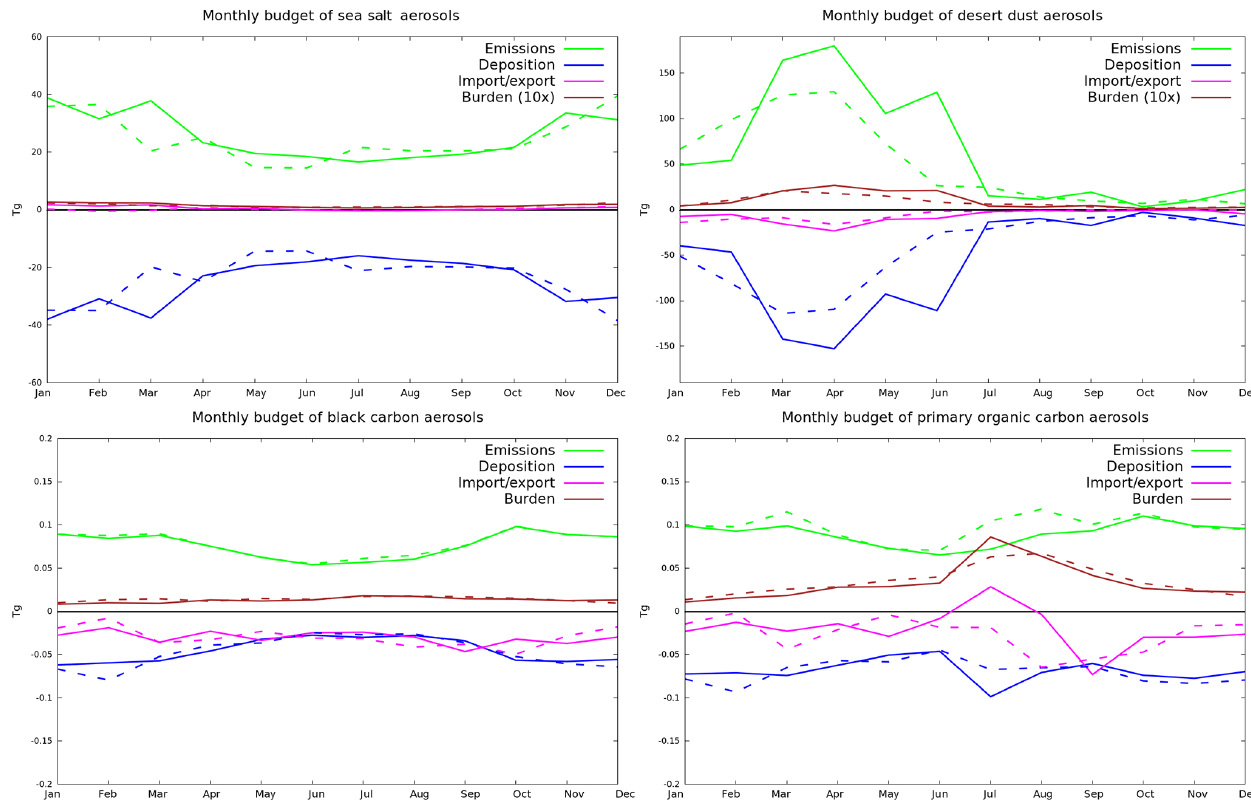
Figure 7. Monthly budget for the total mass of primary aerosols for the year 2012 (dashed lines) and 2013 (solid line). The green lines correspond to the emissions, the blue ones to deposition, the pink ones to the import or export part and the brown ones the